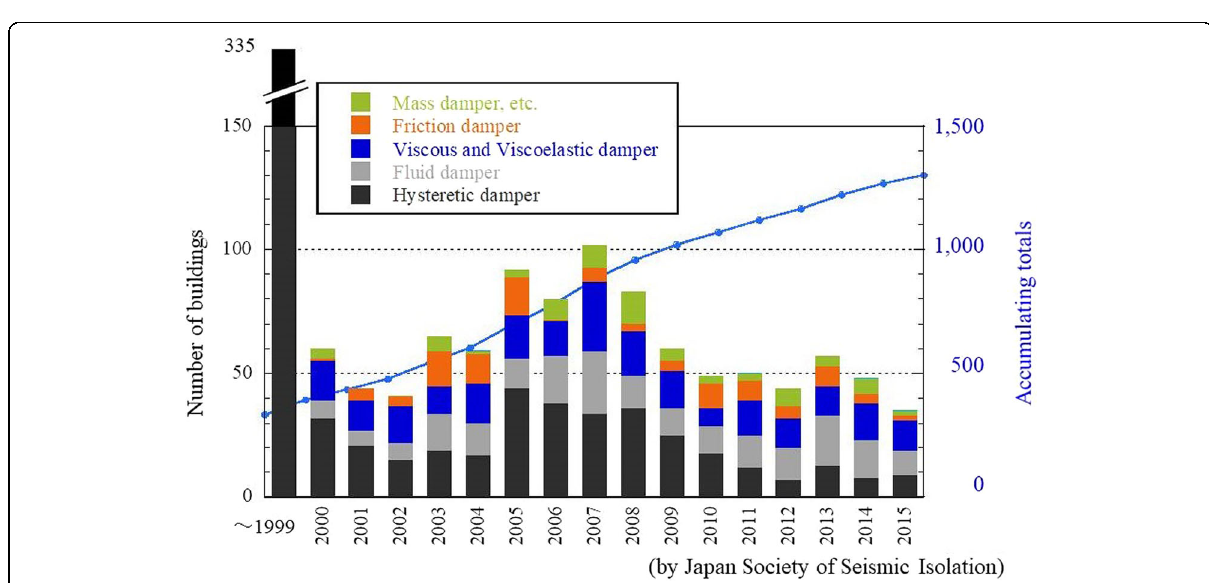
Fig. 20 Application of Response Control Methods in